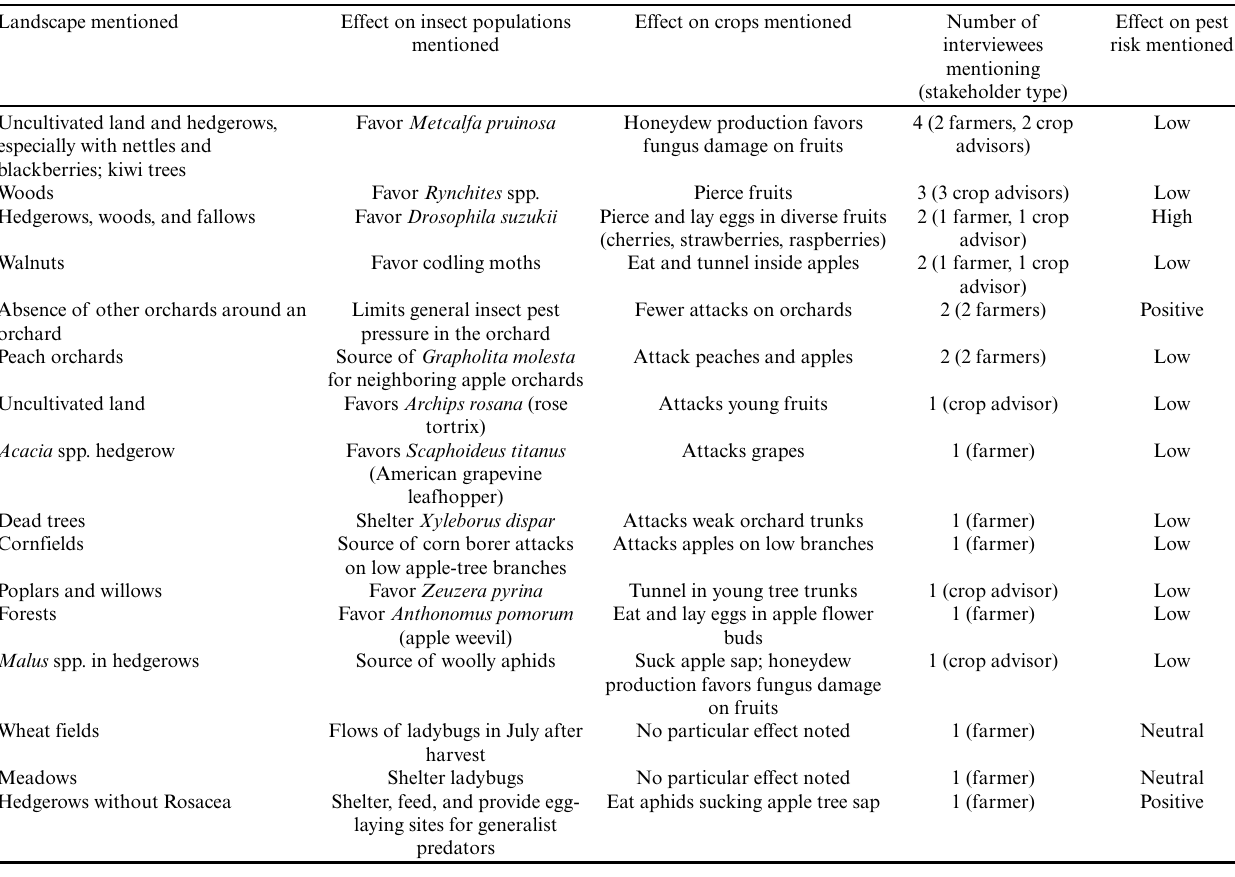
Table 3. Characteristics of landscape elements mentioned during individual interviews and their effect on insect